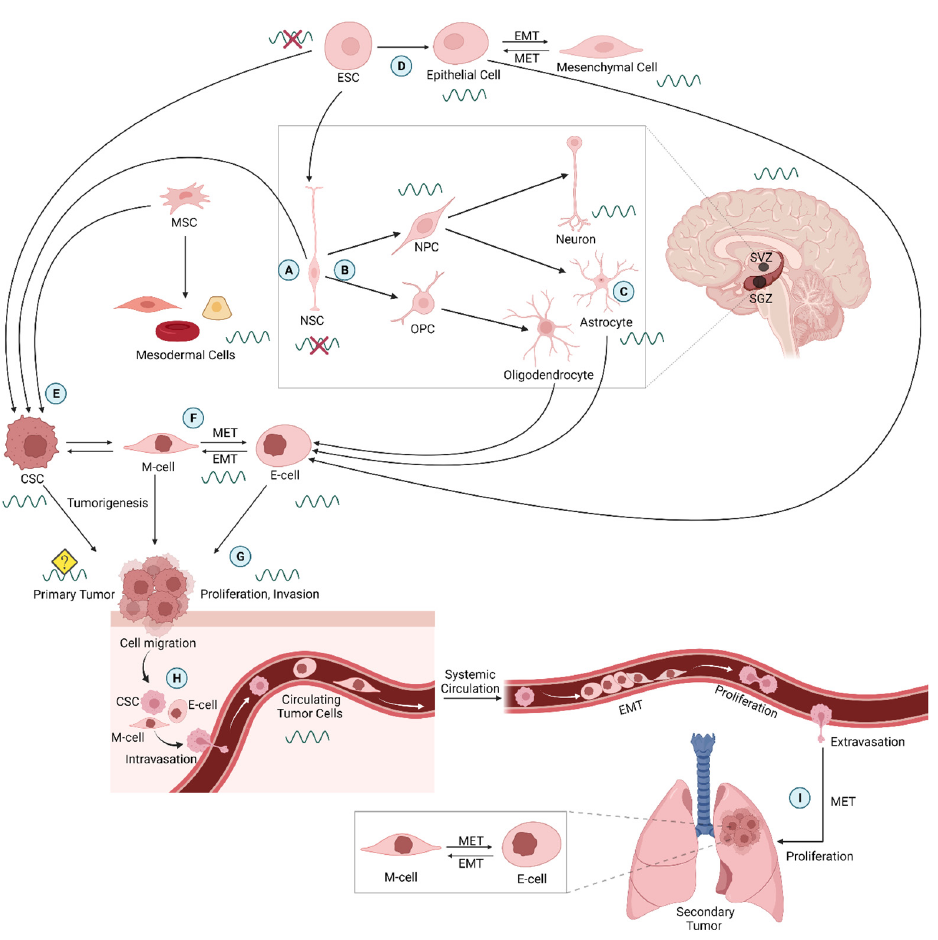
Figure 2. Circadian properties of stem cells and their lineages during development and cancer. Circadian rhythms have been identified at several cell stages (indicated by sine waves); although, evidence during some critical steps remains lacking. See text for additional explanation. ( A ) Circadian rhythms appear to be absent in ESCs and NSCs but emerge as cells differentiate into NPCs and then mature cells. ( B ) Circadian rhythms have been described in differentiating ESCs, adult NSCs, and immature neurons (neuroblasts) in culture [29]. ( C ) Intrinsic circadian rhythms have been identified in a great many mature cell types including neurons and astrocytes [30]. The possibility of circadian rhythms in oligodendrocytes and OPCs has been evaluated; although, evidence is not yet conclusive [31,32]. ( D ) Additional exploration is needed to identify possible circadian rhythms in EMT or MET during development or in non-cancerous adult stem cells such as during growth and tissue repair. Circadian rhythms in melatonin levels may modulate EMT [33–35]. ( E ) CSCs may originate directly from adult NSCs, ESCs, or possibly MSCs [36,37]; although, evidence of circadian control of this process is lacking. NSCs of the subventricular zone of the lateral ventricles can generate glioblastomas [38]. ( F ) CSCs also result from M-cells through dedifferentiation of E-cells during EMT, which is reversed by MET. Studies have shown control of EMT by core circadian clock genes [39–41]. Circadian clocks in cancer cells control EMT events in glioma and breast cancer cells [42]. Nevertheless, it is not yet known whether M-cells are rhythmic. Any M-cells formed from MSCs, through EMT or possibly mesenchymal cell transformation, are presumed to be rhythmic based on rhythms in the closely related CSCs. Circadian rhythms have been observed in CSC cultures [43,44]. M-cells transition into CSCs, but already have some stem cell characteristics. ( G ) Circadian rhythms have been observed in glioma, lung carcinoma, melanoma, and other cancer cell cultures primarily consisting of E-cells; although, low numbers of M-cells or CSCs can be present [45–47]. Circadian rhythms in tumor growth and cell proliferation have been reviewed recently [11,48]. Circadian tumor stromal cells and control of the tumor microenvironment and metastasis has been described